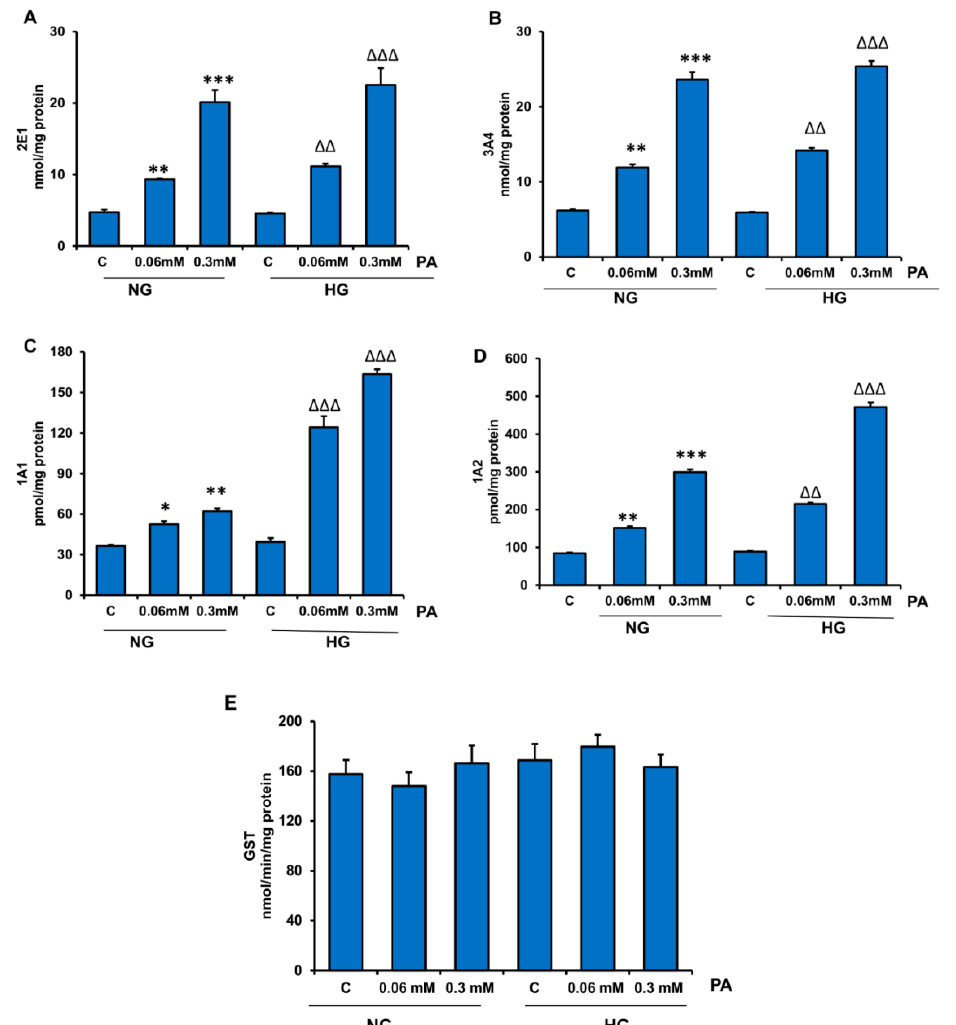
Figure 7. Effect of HG/HPA on CYP450 and GST activities. HepG2 cells were treated with high glucose and high fatty acids, and the activities of different CYP450 enzymes ( A – D ) and GST ( E ) were measured using the appropriate substrates, as described in the Materials and Methods section.